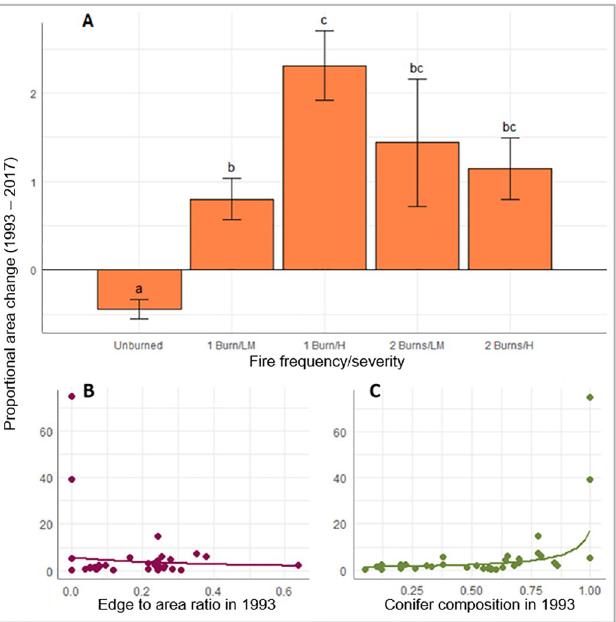
Fig 8. Proportional area change between 1993 and 2017: A) Fire frequency and severity category least squares means and standard errors, B) the effect of edge:area ratio in 1993 and C) the effect of conifer composition in 1993. Error bars represent standard error and letters above each category represent the difference among categories, same letters denoting no significant difference. The plotted dots in B and C are the observed relationships between the two variables, and the curves superimposed over stand data represents expected values across range of predictor variable while other variables are held constant at their mean value.